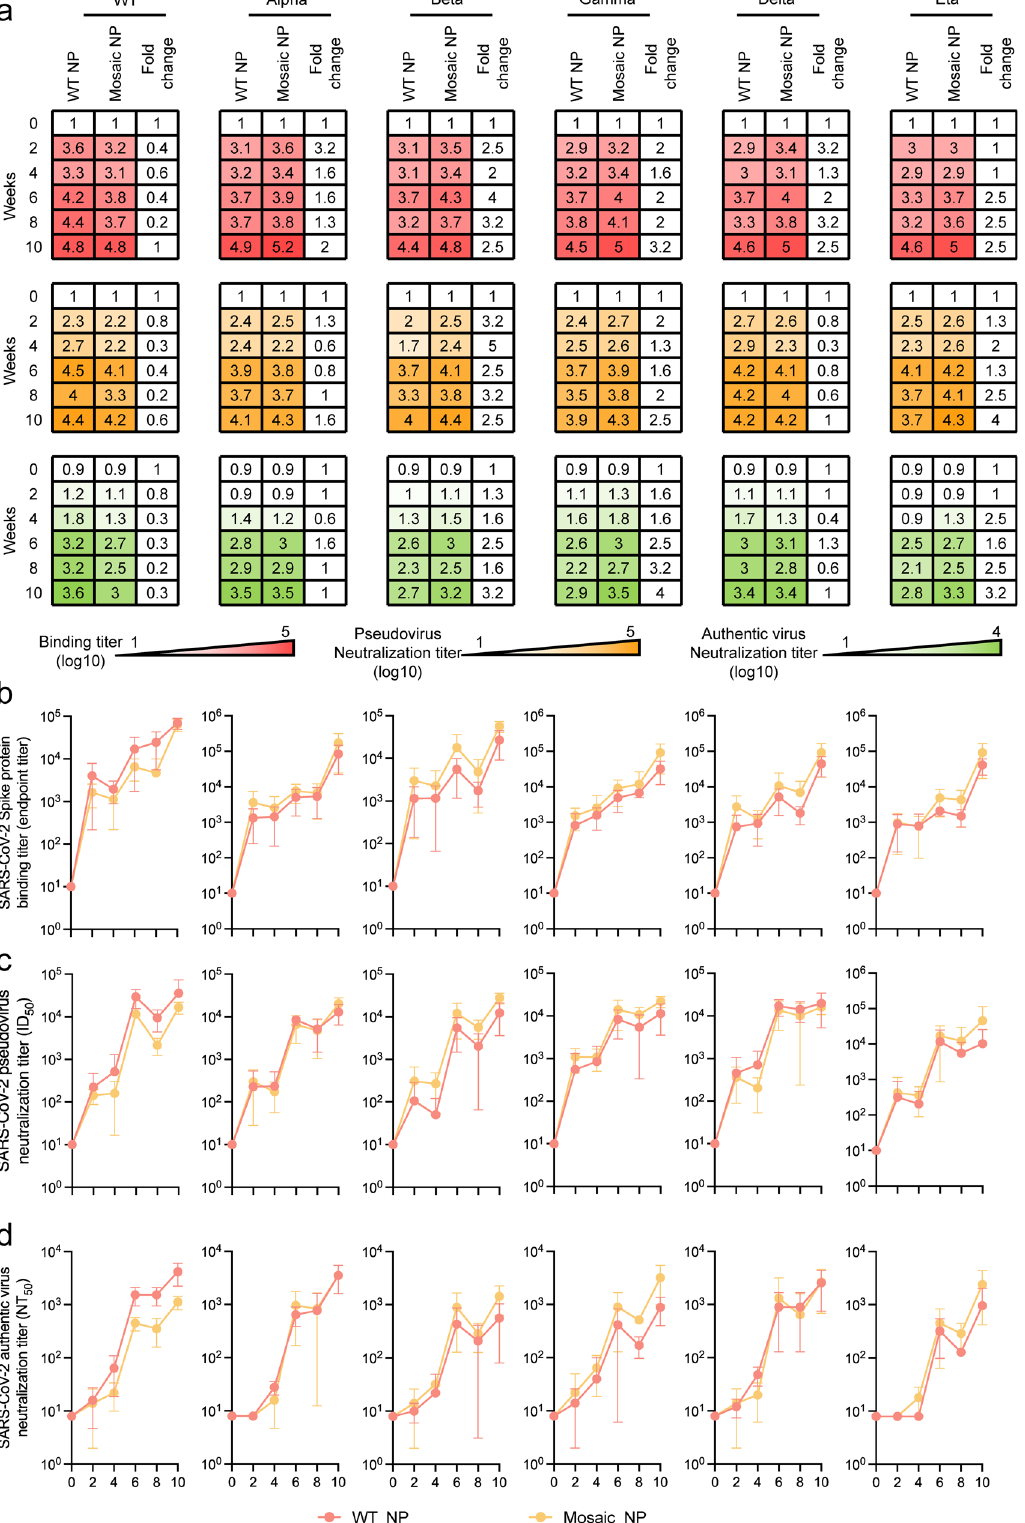
RATG13 pseudoviruses. Following 2 weeks after the third immunization, non-human primates vaccinated with Mosaic NP exhibited higher levels of neutralization antibodies against all SARS-related pseudoviruses than those vaccinated with WT NP (Supplementary Fig. 3). To further investigate the magnitude of binding antibodies elicited by the HexaPro-based nanoparticle